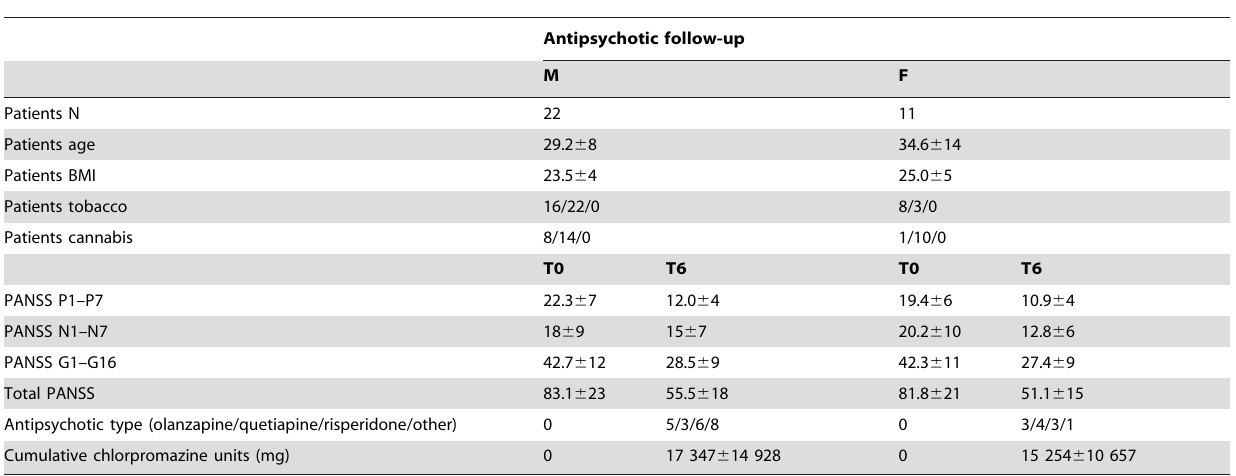
covariate adjustment, we also performed interaction tests using the non-parametric aligned rank transform method without using additional covariates [15,16]. Analytes found to have significant sex-diagnosis interactions (P , 0.05 and Q , 0.30) were stratified by sex and re-analysed. This was repeated within each cohort to investigate the consistency of sex-specific patterns. The same procedure was used across all schizophrenia cohorts to identify potential molecular interactions between sex and positive, negative, and total PANSS scores in schizophrenia patients. Average correlation coefficients between analyte levels and scores across cohorts were found using Fisher’s z transformation [17]. Table 2. Demographics for treated schizophrenia